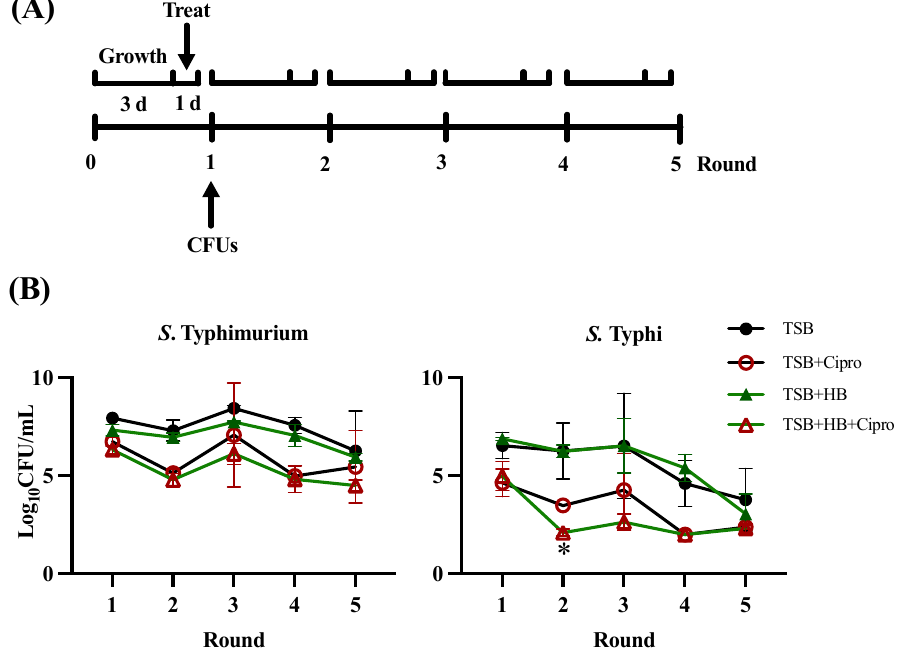
Figure 5. Multiple rounds of ciprofloxacin treatment on biofilms. ( A ) Experimental set-up; growth, treatment, and CFU counts for rounds 2–5 were performed the same as for round 1. ( B ) Colony forming units recovered for S . Typhimurium 14028 and S . Typhi Ty2 laboratory strains in different growth conditions after every round of ciprofloxacin treatment (red symbols) vs. control total cell numbers (black and green symbols). Representative charts are shown from one experiment performed with four or more biological replicates and repeated at least three times with similar results.